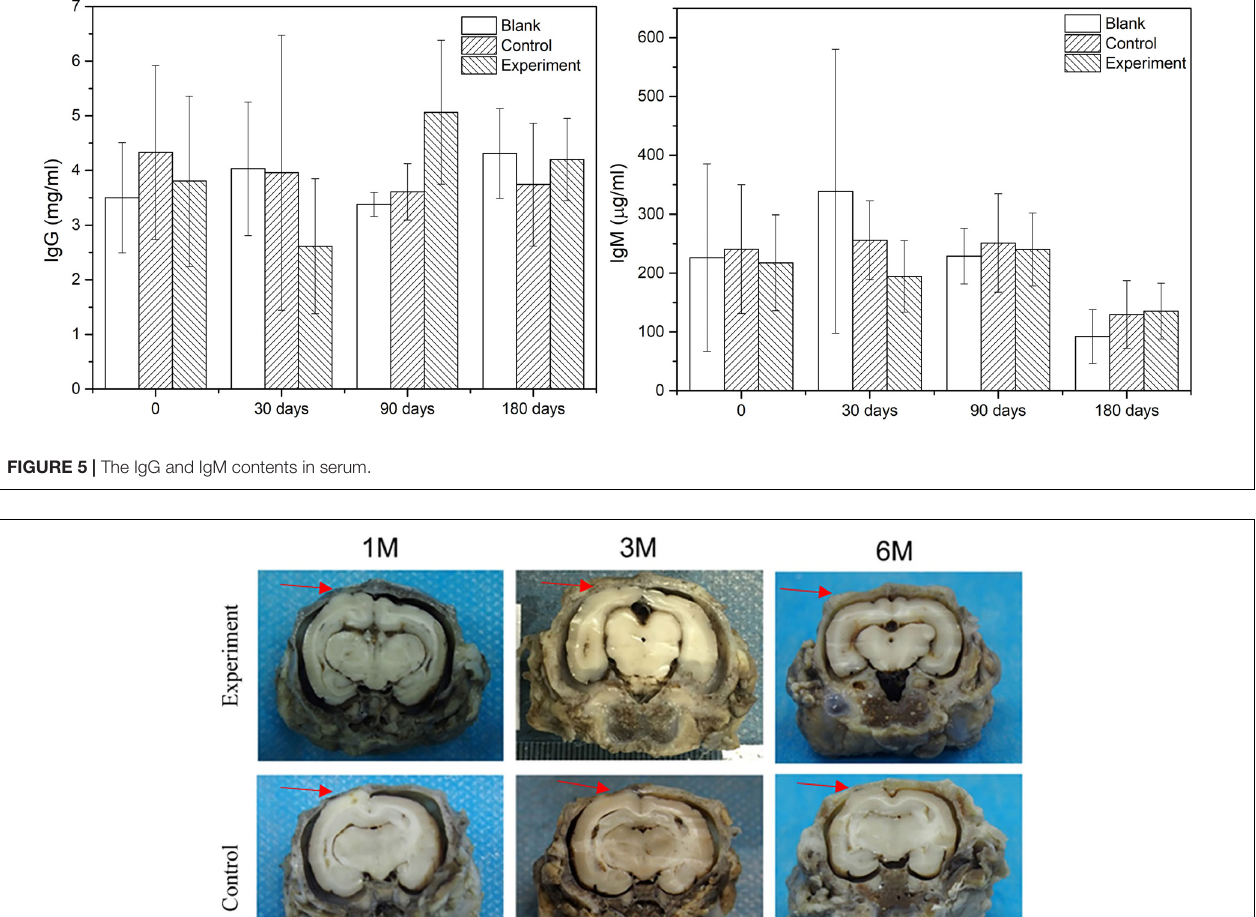
structure with inter-connected pores of diameters ranged from a few to 150 µ